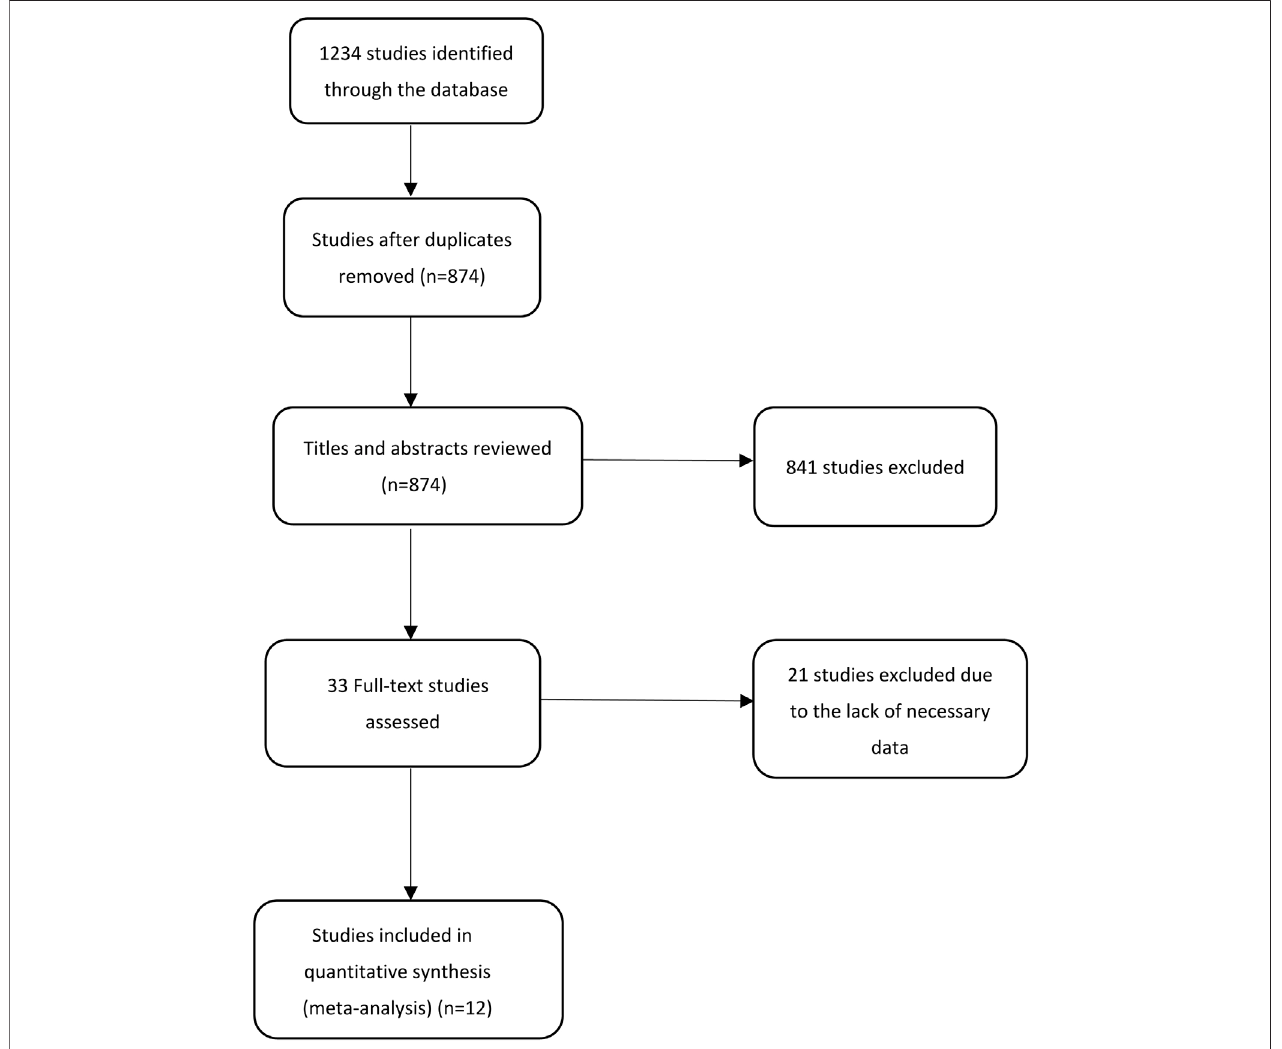
FIGURE 1 | Selection process for studies included in the pooled- analysis.